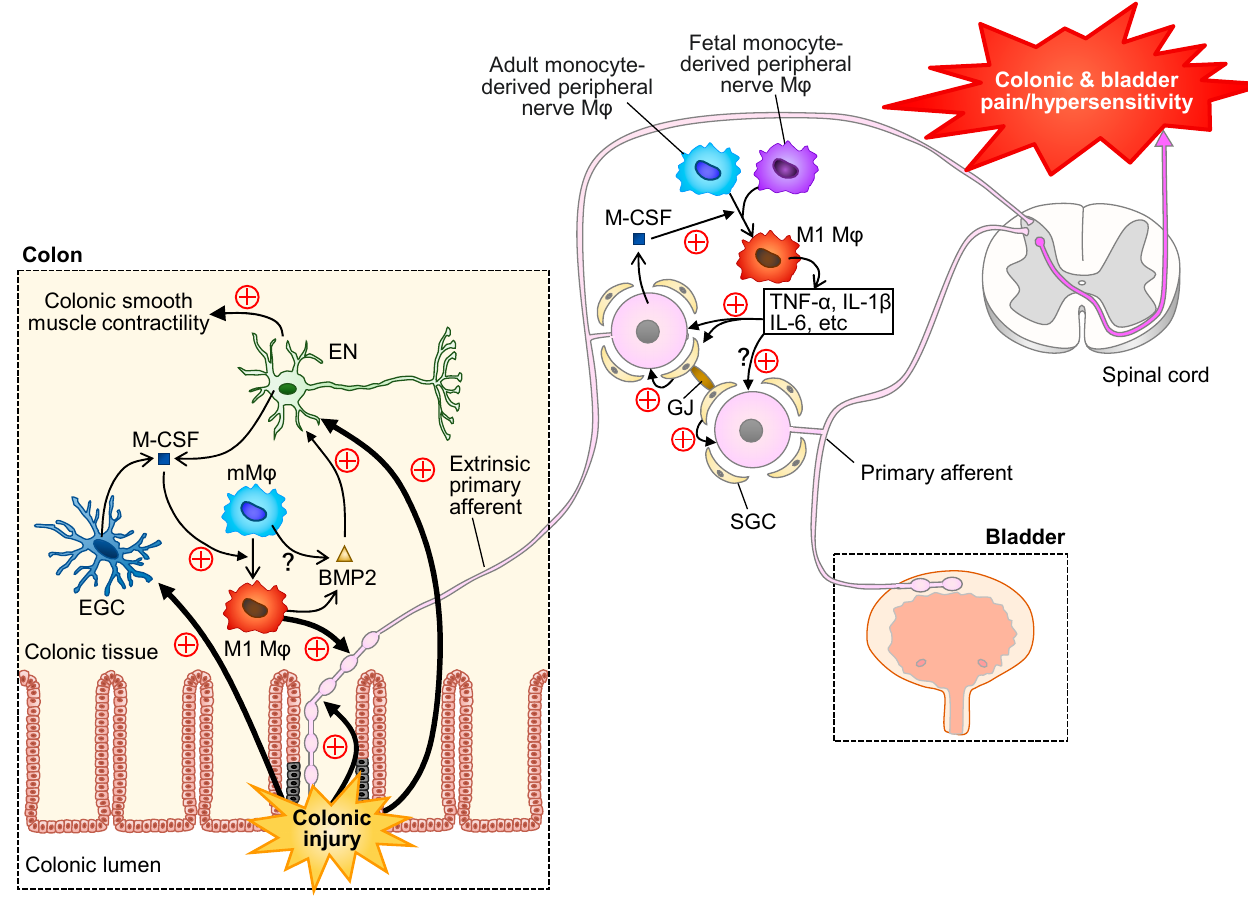
Figure 4. Neuron-glia-macrophage (M φ ) interaction in the DRG and enteric nervous system participates in colonic pain/hypersensitivity followed by bladder pain/hypersensitivity. Colonic injury causes stimulation of the extrinsic primary afferents, enteric nerves (ENs) and enteric glial cells (EGCs). Macrophage colony-stimulating factor (M-CSF) derived from the activated ENs and EGCs stimulates the polarization of muscularis macrophages (mM φ ) to pro-inflammatory M1 macrophages that enhance the excitability of the primary afferents. Macrophage-derived bone morphogenic protein 2 (BMP2) stimulates ENs that regulate colonic muscle contractility. In DRG, the injured primary afferents following colonic inflammation release M-CSF, which stimulates and polarizes peripheral nerve macrophages derived from fetal and adult monocytes to M1 fenotype. The activated macrophages release pro-nociceptive cytokines including TNF- α , IL-1 β and IL-6, thereby stimulating the primary afferent neurons and satellite glial cells (SGCs). Gap junctions between adjacent SGCs mediate transmission of neuronal excitability from the injured primary sensory neurons following colitis to the non-injured primary sensory neurons innervating the bladder, leading to cross-organ sensitization, i.e., co-occurring colonic and bladder pain/hypersensitivity.